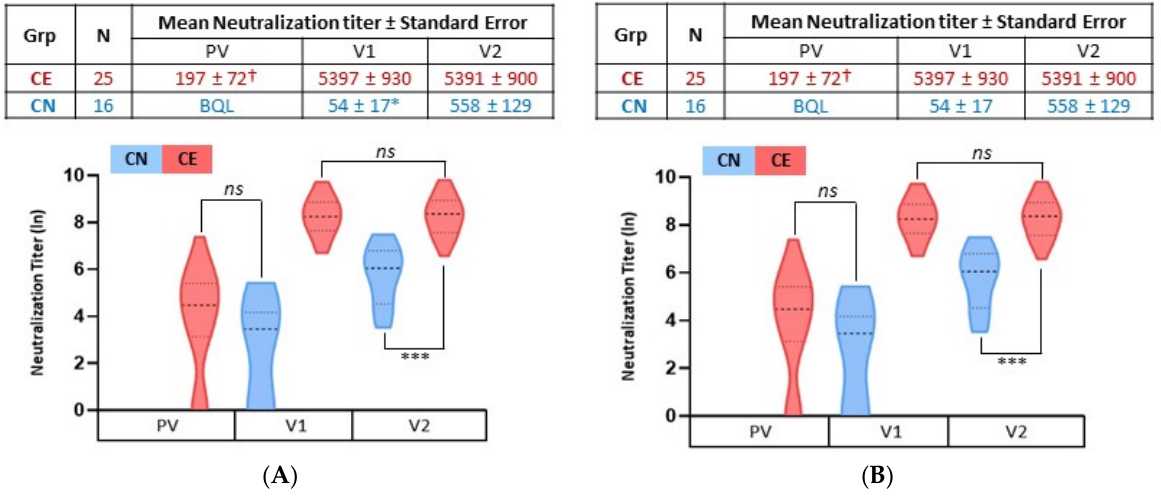
Figure 4. SARS-CoV-2 neutralization titer after mRNA vaccination. Serially diluted serum samples were subject to an infectious SARS-CoV-2 microneutralization assay to determine the dilution at which virus neutralization was lost. ( A ) The mean neutralization titer (NT) ± standard error of COVID-19-experienced (CE; red) and COVID-19-naïve (CN; blue) groups were calculated for samples obtained pre-vaccination (PV), 3 weeks after the first vaccine dose (V1), and 3 weeks after the second vaccine dose (V2). ( B ) The natural log of the mean NT and quartiles are graphed (y-axis). † Samples BQL were assigned a value of 1 in calculation of means and for ln transformation in the graph. ns = not significant. *** represents p < 0.001. * p <